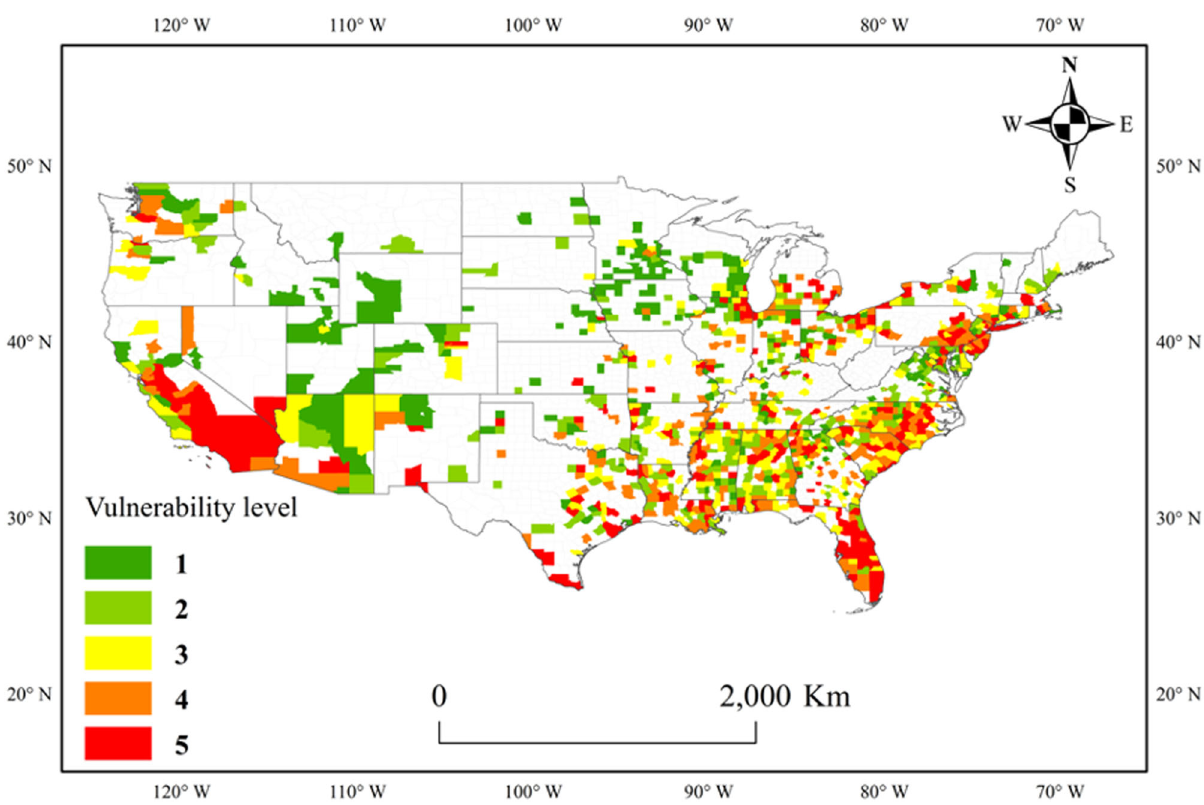
Fig. 1 Spatial distribution of counties with different vulnerability levels, as measured by the CPVI. The CPVI values are divided into fi ve levels based on quintiles, where 5 indicates the most vulnerable communities and 1 indicates the least vulnerable communities. White areas indicate counties where no data are